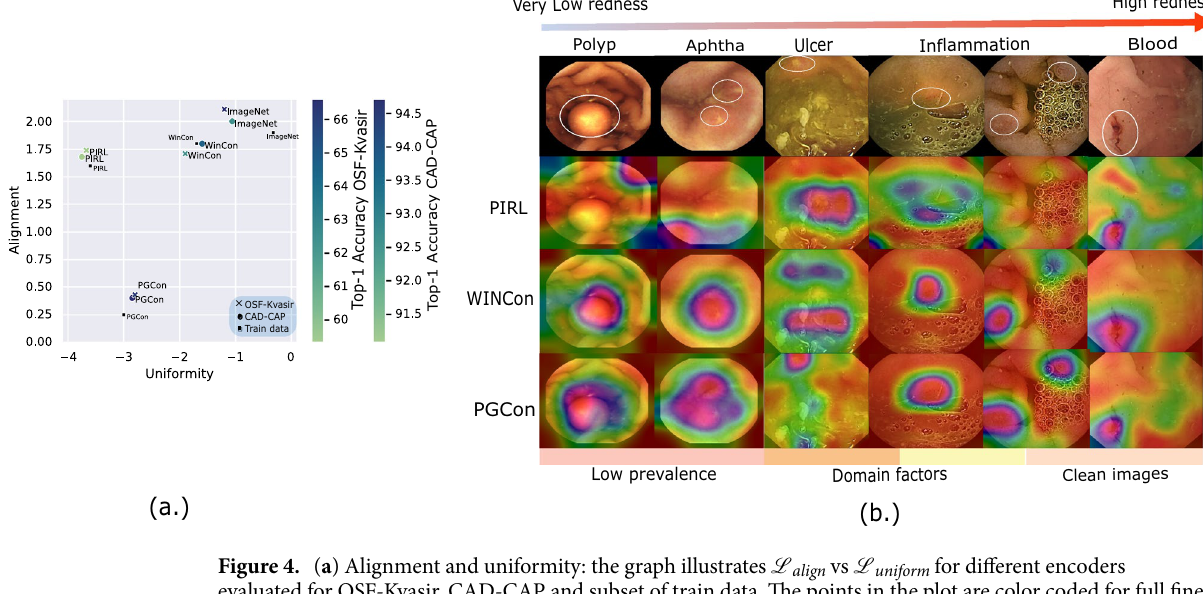
Figure 4. ( a ) Alignment and uniformity: the graph illustrates L align vs L uniform for different encoders evaluated for OSF-Kvasir, CAD-CAP and subset of train data. The points in the plot are color coded for full fine tuning accuracy. ( b ) Activation map: visualization using ScoreCAM 39 shows the effectiveness of our approach for non-red (polyp, ulcer) and low prevalence (in train and test sets) pathologies. It also shows that WINCon exhibits higher locality compared to PGCon. For more visualizations refer to the supplementary